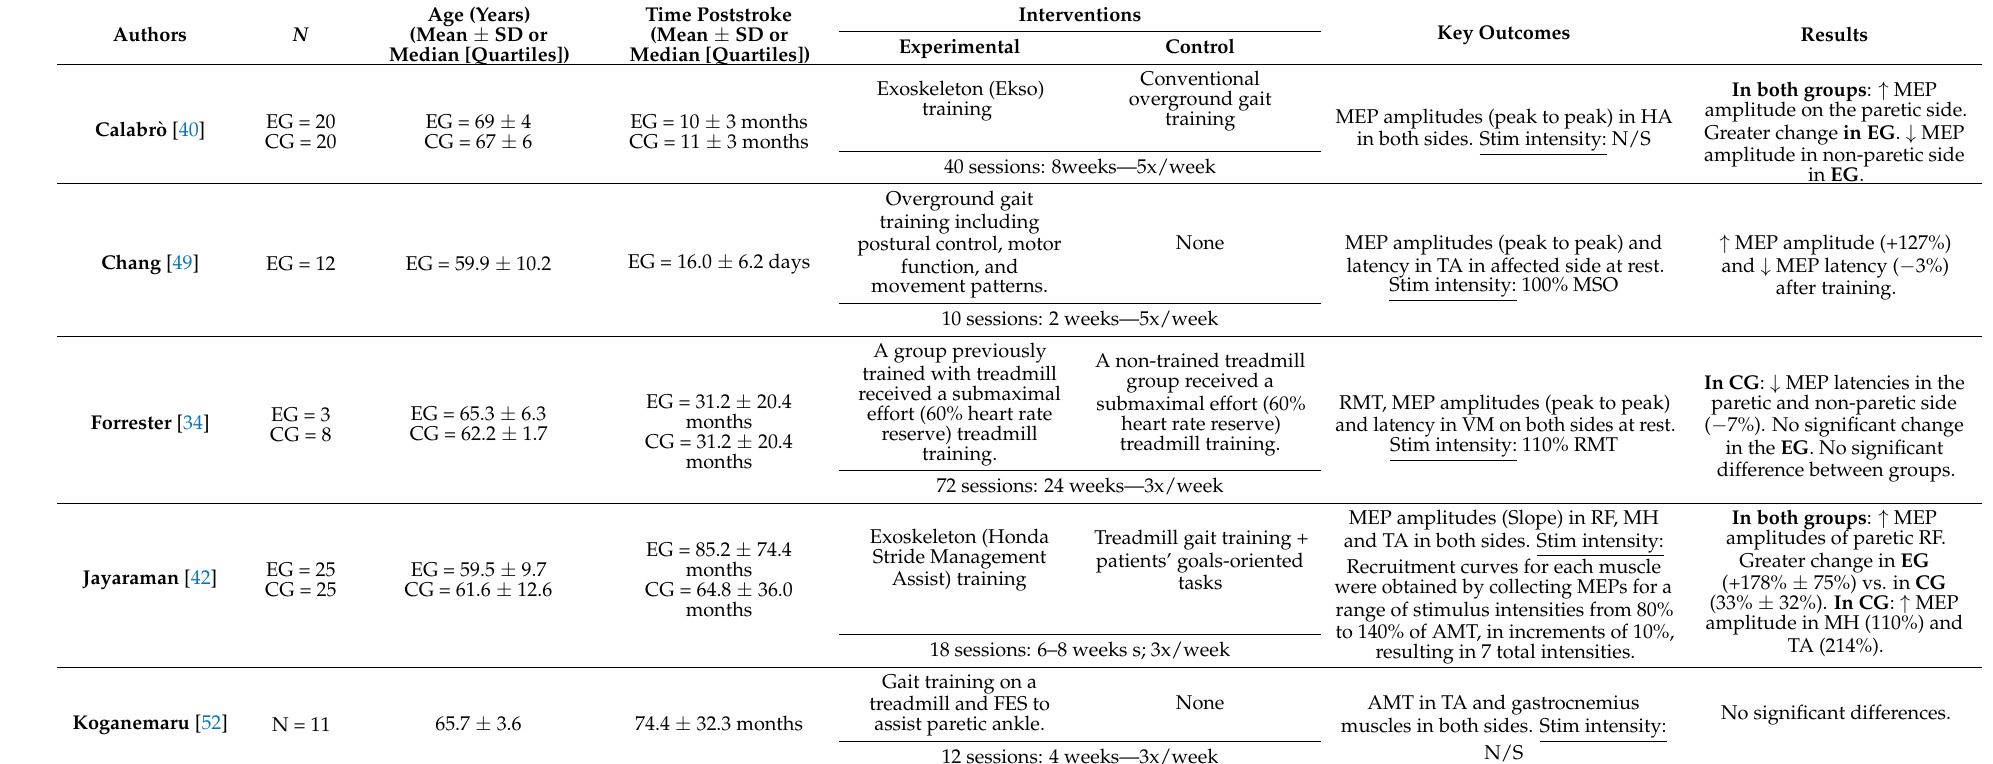
Table 3. Summary of studies: populations, interventions, outcomes and